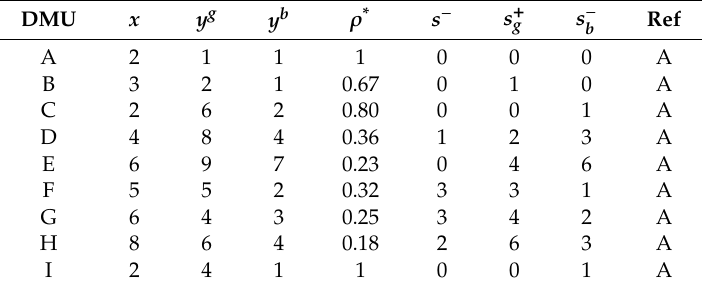
Table 2. SBM with good and bad outputs and slacks with the additive model.